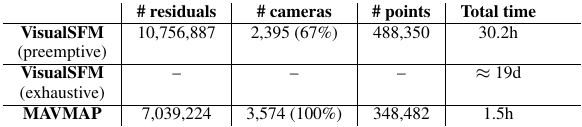
Table 1: Reconstruction results for Rubble 1